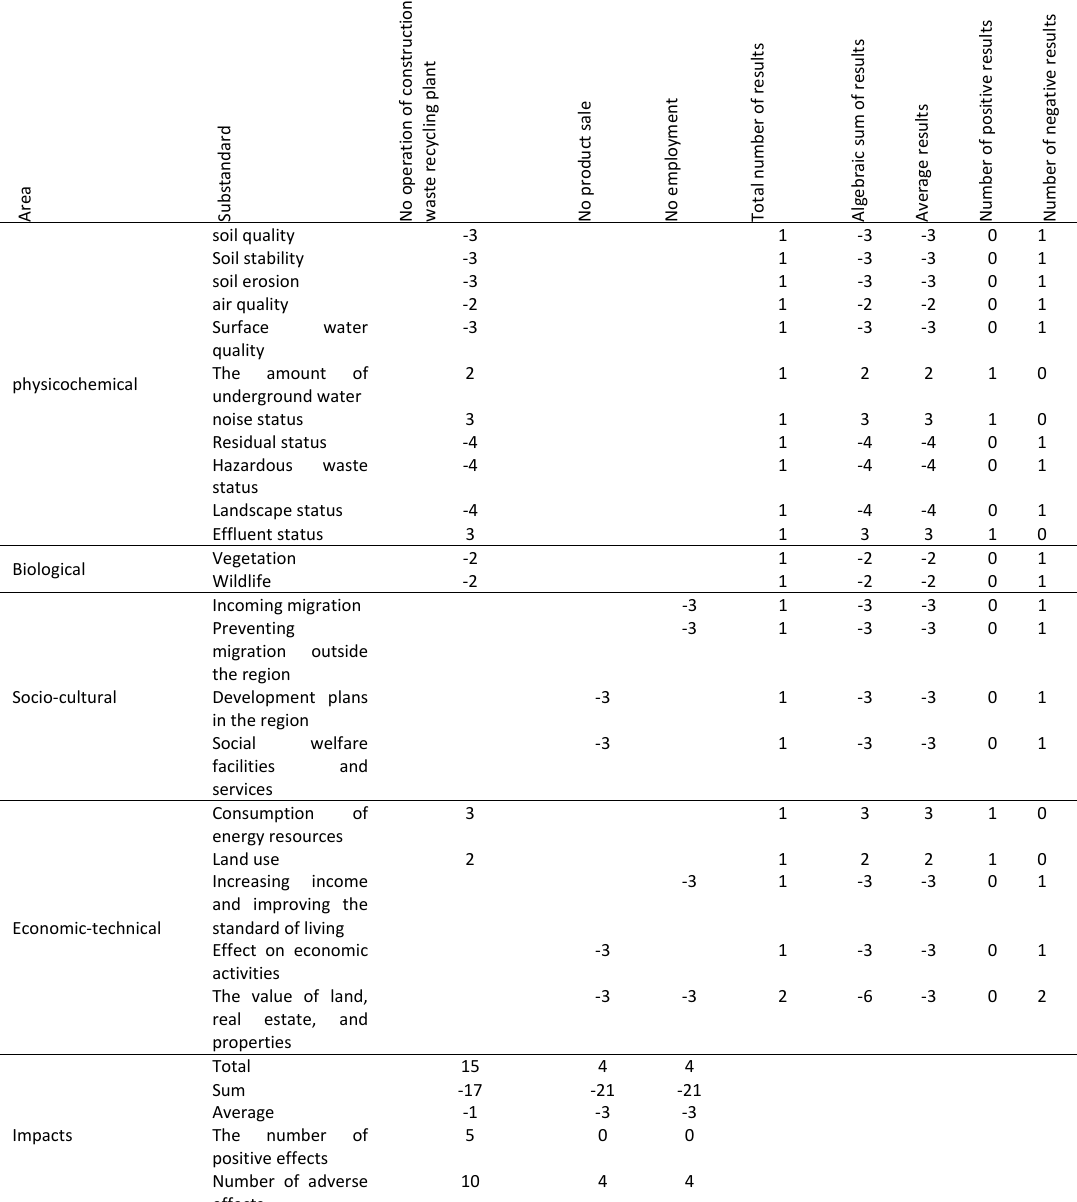
Table 1: Ranking of environmental indicators for no implementation plan at operational phase